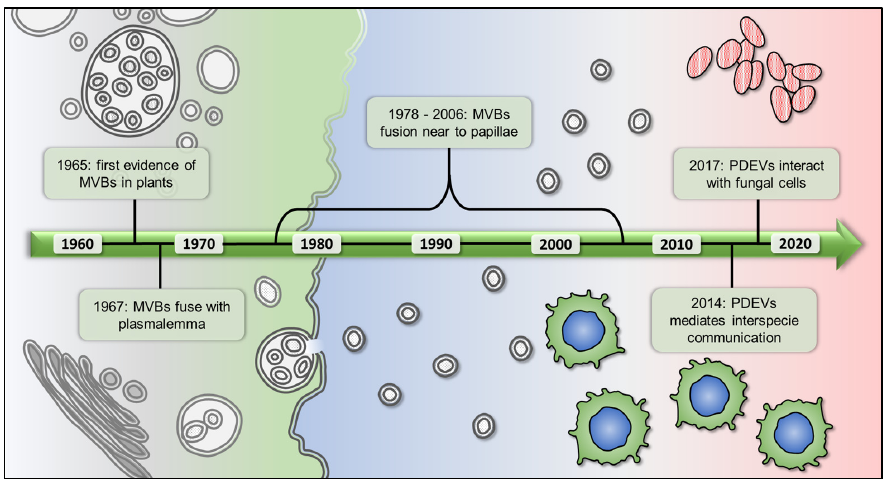
Figure 1. Timeline of plant-derived extracellular vesicles research. The first observation of PDEVs came from electronic transmission microscopy in the 1960s. For several years they were correlated to the response against pathogens, until it their capability to mediate the cross-kingdom communication was demonstrated. MVBs, multivesicular bodies; PDEVs, plant-derived extracellular